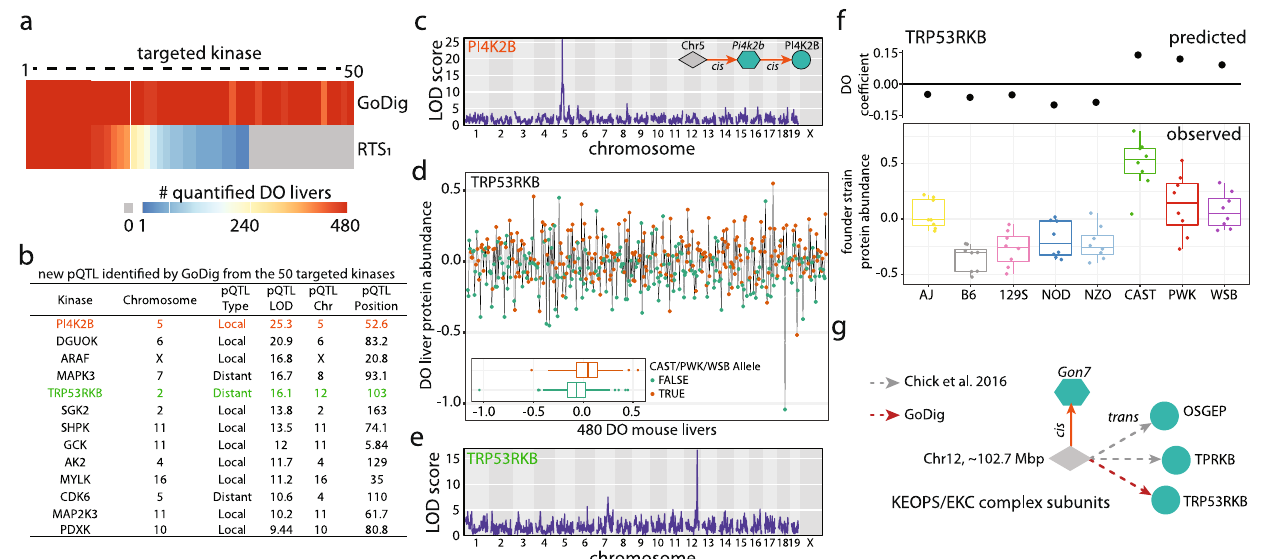
Fig. 5 | GoDig identi fi es previously undetected pQTL across 50 targeted kina- ses. ExperimentaloverviewisillustratedinFig.4a.Fiftykinases,includingforty-six that had no annotated pQTL in Chick et al. 35 , were targeted and measured with GoDig. a Heatmapofkinasedetectionacrossthe480samples.Datawerecollected using GoDig or single-shot RTS (RTS 1 ) and a 2-h method/plex. Gray indicates the protein was not quanti fi ed in any sample. Less than 30% of kinases were con- sistentlydetectedacrossthe480samplesusingMS1-baseddetection(RTS 1 ). b New pQTL identi fi ed by GoDig for the 50 targeted kinases. c Genome scan for PI4K2B pQTL. LOD score represents the statistical strength of genetic association. PI4K2B abundance is regulated by a local pQTL on chromosome 5. PI4K2B abundance is likely regulated through a transcriptional mechanism because a corresponding local eQTL was reported by Chick et al. 35 . The founder allele effects of the eQTL is consistent with that of the pQTL identi fi ed by GoDig (Supplementary Fig. 7). d TRP53RKB protein expression across the 480 DO mice are arranged along the x axisbyTMTpro16labelingorder.TheinsetshowstheboxplotofTRP53RKBprotein